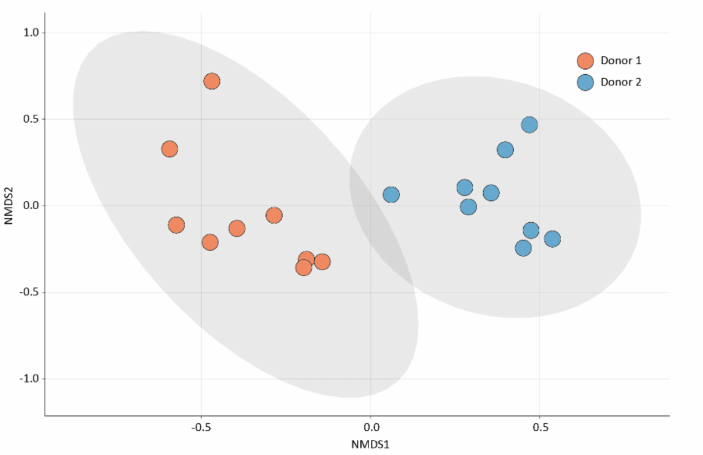
Figure 3. Two-dimensional non-metric multidimensional scaling (nMDS) plot of the microbial community compositions in the donor samples. An nMDS plot based on the Bray–Curtis dissimilarity matrix was used to simultaneously visualise individual samples (dots) originating from donor 1 (D1, red) and donor 2 (D2, blue). Sample clustering of the two donors was significantly different (PERMANOVA, p =